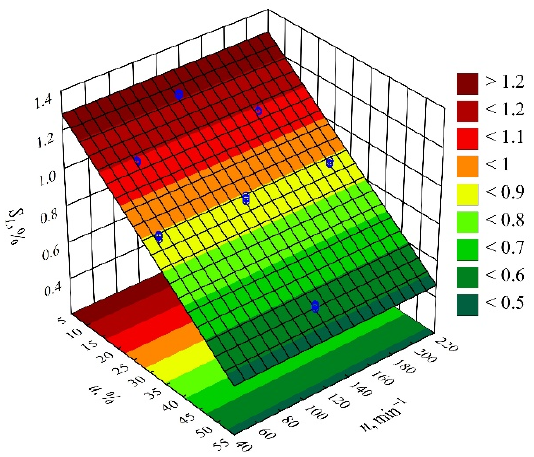
Figure 4. Response surface graph for the longitudinal shrinkage S L versus wheat bran content u and screw speed n.